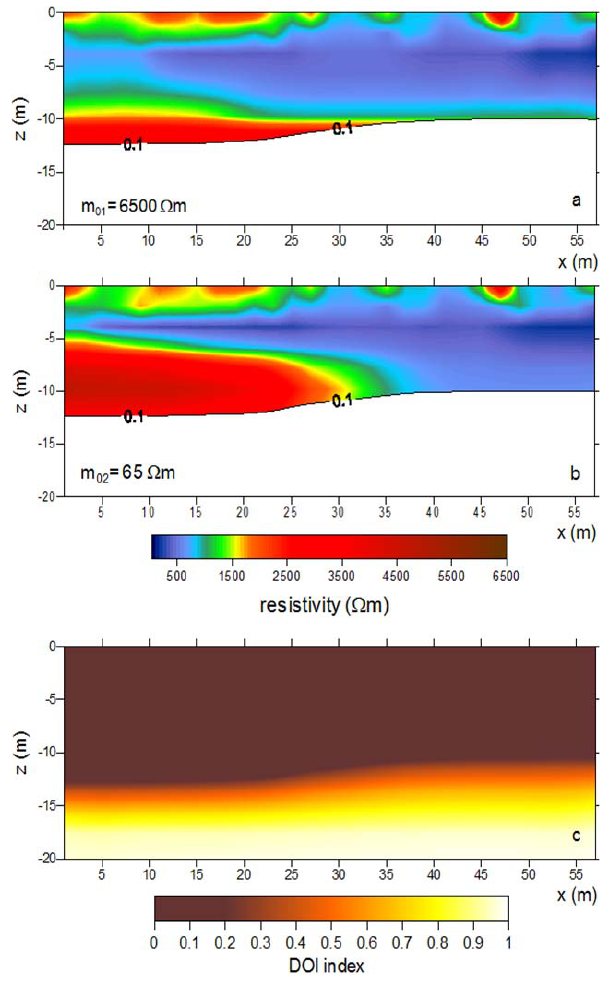
Fig. 3. Inverted resistivity models with factors (a) 0.1 and (b) 10 of average apparent resistivity with a cut-off according to a DOI index > 0 . 1. (c) The calculated depth of interest